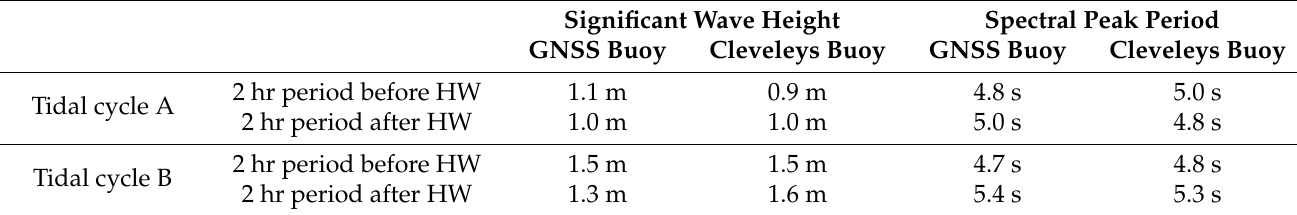
Table 4. Wave parameter comparisons between the GNSS buoy and the Cleveleys wave buoy for two-hour periods either side of high water